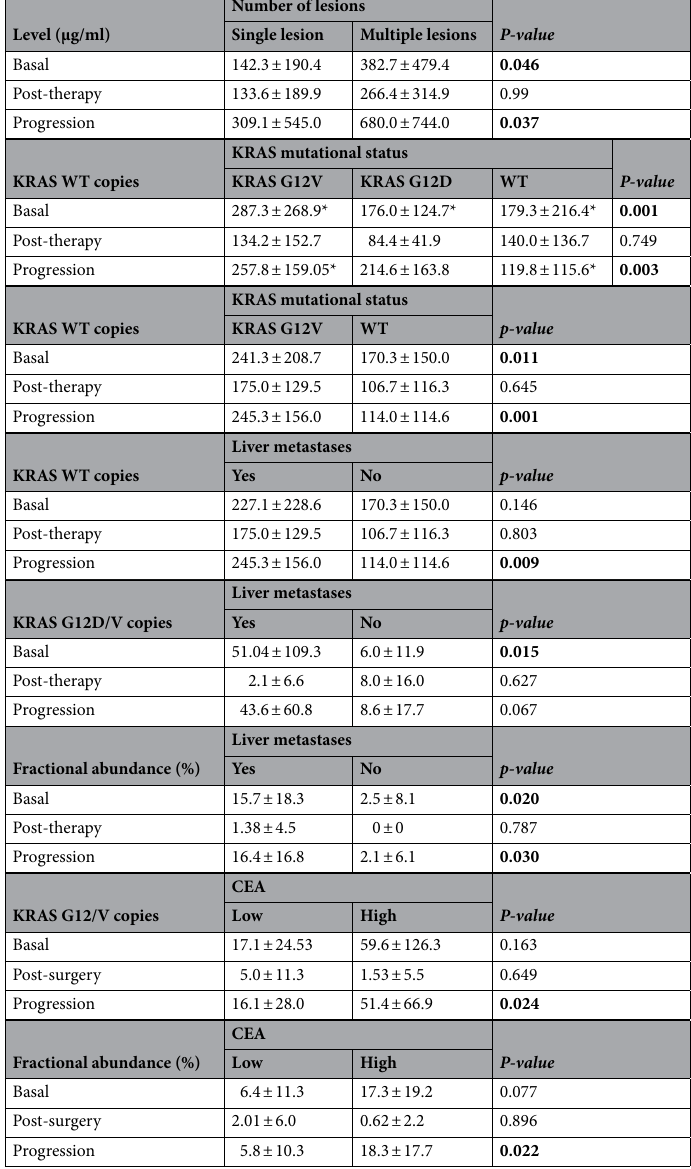
(Fig. 1i) (Table 2). Plasma exosomes levels were not correlated with progression free nor with overall survival in mCRC patients (data not shown). Liquid biopsy is suitable for detection of wild type and mutants KRAS in exoDNA by digital PCR. KRAS G12D/V mutant and wild-type amplicon were analyzed by droplet digital PCR (ddPCR) in plasma exosomes of 60 mCRC patients enrolled in this study (Fig. 2a). The wild type cohort of patients was analyzed by KRAS G12/13 screening kit. To confirm the correct identification of KRAS mutant and wild-type amplicon we used three colorectal cancer stem cell lines (CSC1 carrying mutated KRAS G12V , CSC2 carrying WT KRAS and CSC3